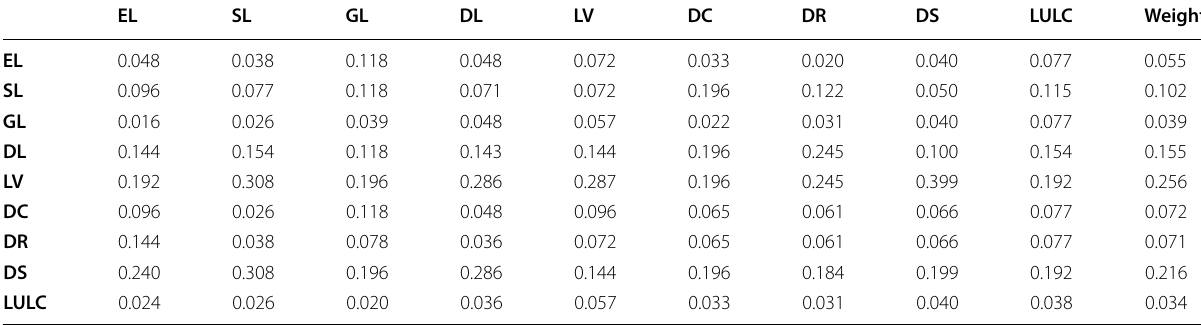
Where, EL, SL, GL, DL, LV, DC, DR, DS and LULC denotes elevation, slope, geology, Distance from lineament, land value, Distance from river & canal, Distance from road, Distance from residence and land use land cover respectively Source: Computed by the